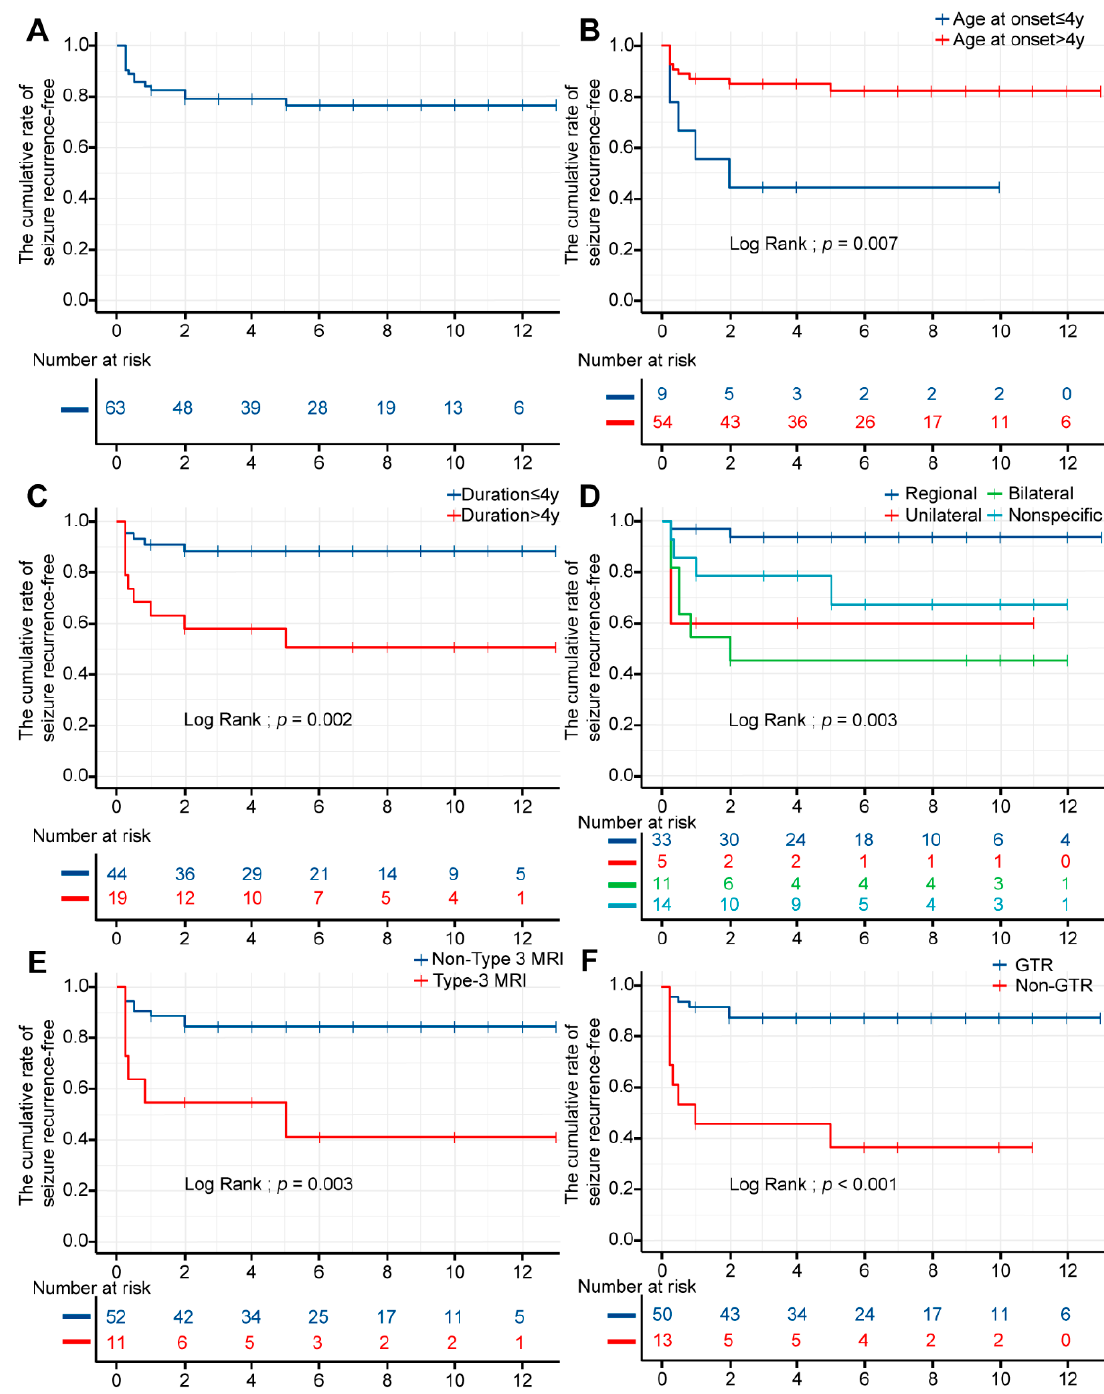
Figure 4. Kaplan–Meier curves for seizure outcomes. The X-axis represents time in years, and the Y-axis represents the proportion. ( A ): The rate fluctuated in the first few years after surgery and gradually stabilized in subsequent years. ( B ): Analysis by age at onset; ( C ): analysis by duration; ( D ): analysis by IEDs; ( E ): analysis by MRI subtype; ( F ): analysis by surgical types. Addition: because of the limited sizes of MRI type 2 and NTR, MRI type 1 and 2 were classified as Non-Type 3, STR and NTR were classified as Non-GTR in this Kaplan–Meier